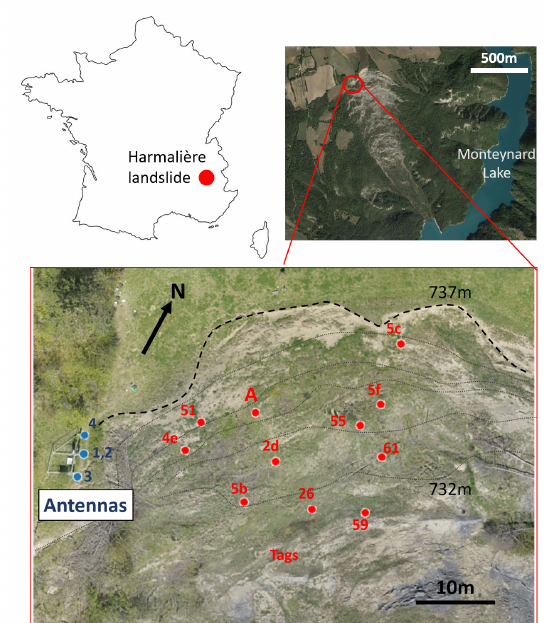
Figure 1. ( Top ) The Harmalière landslide location in France. ( Bottom ) Overview of the Harmalière landslide, with the RFID tag distribution (red points). Blue points : antennas and acquisition system. The dotted black line represents the landslide scar, the gray dotted lines represent 1-meter